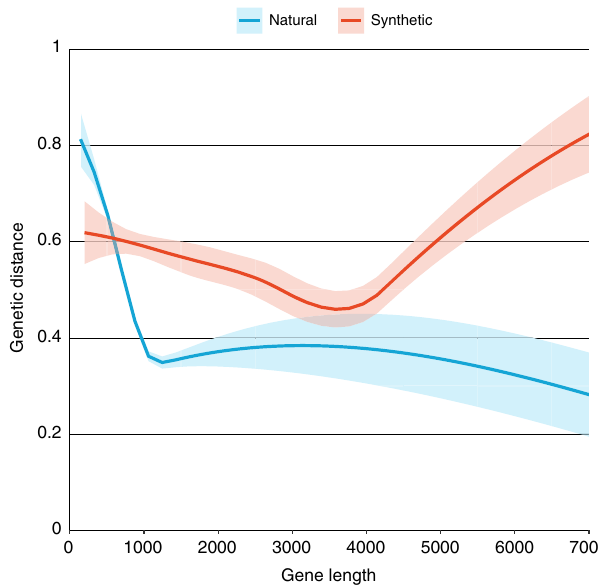
Fig. 4 Local regressions (LOESS) of genetic distance and gene length for natural and synthetic sequences in the Addgene database. Bands show one standard error in each direction, loess smoothed (span = 0.9)